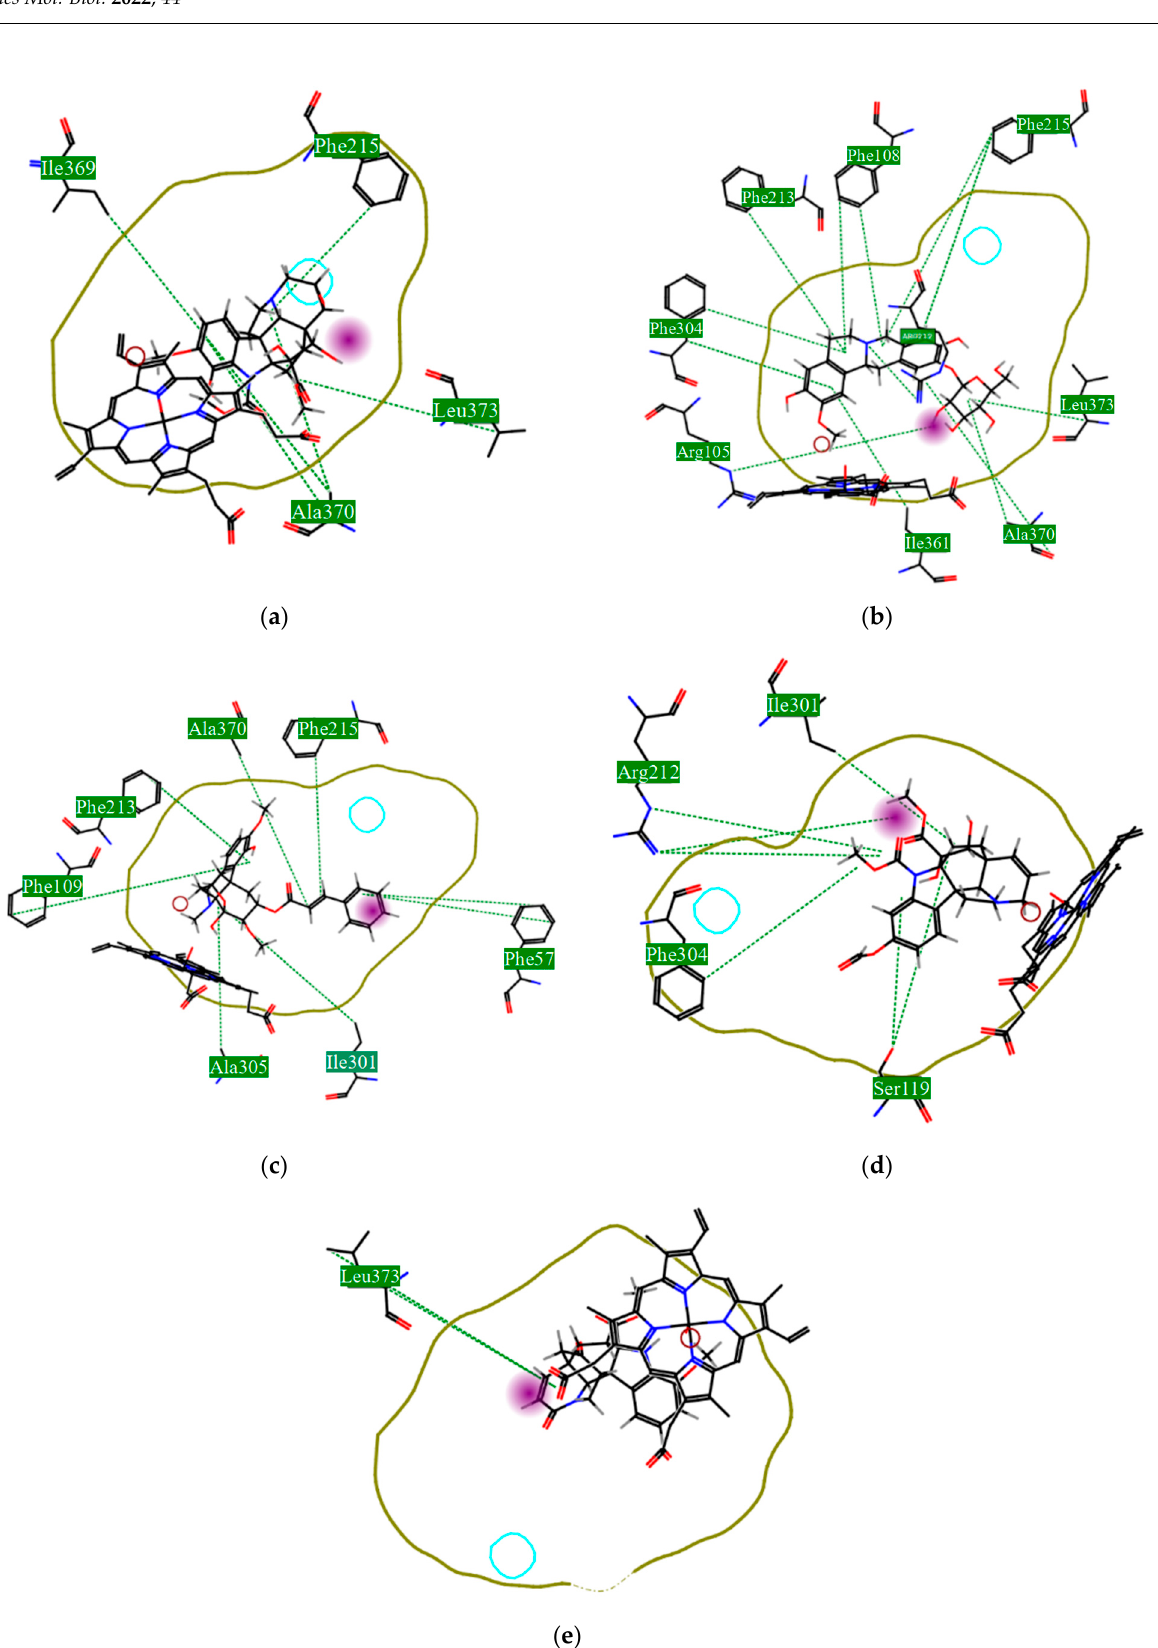
Figure 6. Structural contribution of the molecular coupling between the leading compounds and the liver isoform 3A4 in ( a ) kopsimaline C, ( b ) dauricoside, ( c ) stephalonine D, ( d ) 11,12-methylemedioxykopsaporine and ( e ) methyl-3-oxo-12-methoxy-n(1)-decarbomethoxy-14,15- didehydrochanofruticosinate.